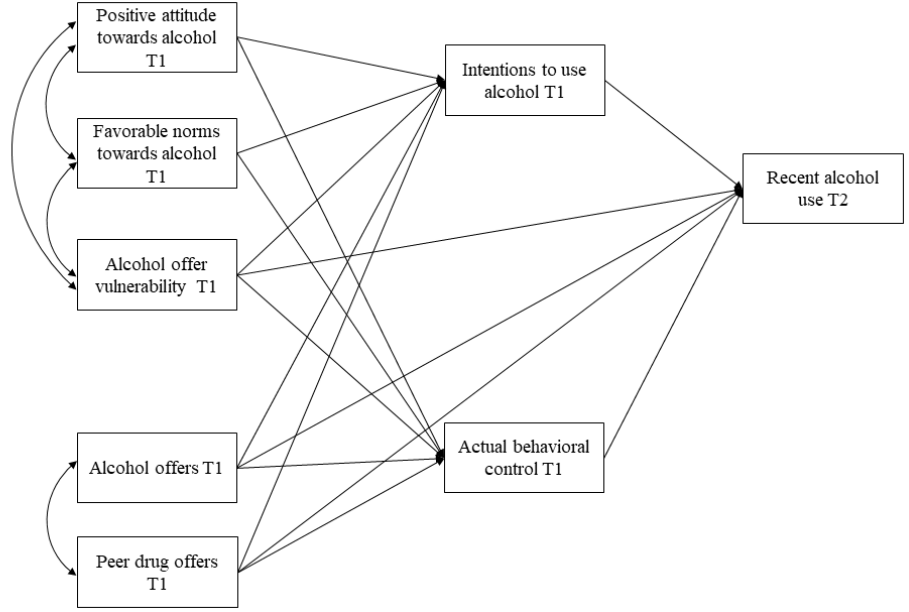
Figure 3. General Path Model Predicting Recent Alcohol Use (Alcohol Frequency and Heavy Drinking Separately).